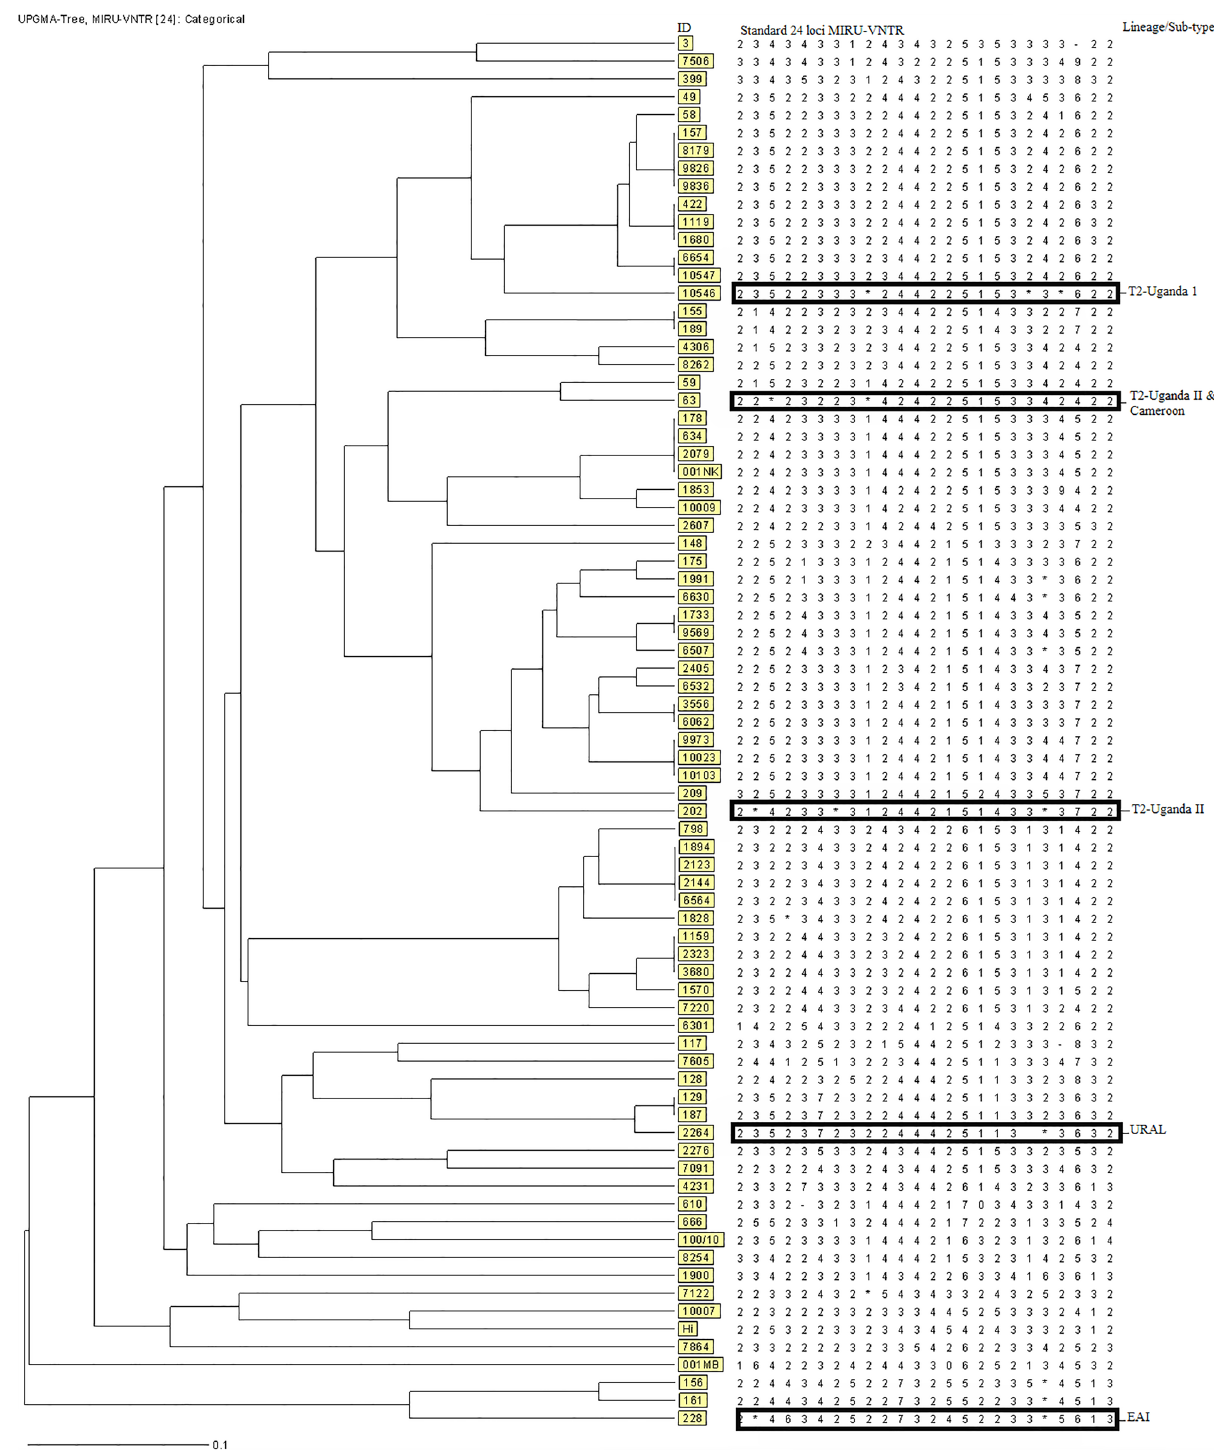
Figure 1. UPGMA tree based on the standard 24 loci MIRU-VNTR of MTB recovered from PTB patients in Southwestern, Uganda. Lineage sub-type identified by MIRU-VNTR plus similarity